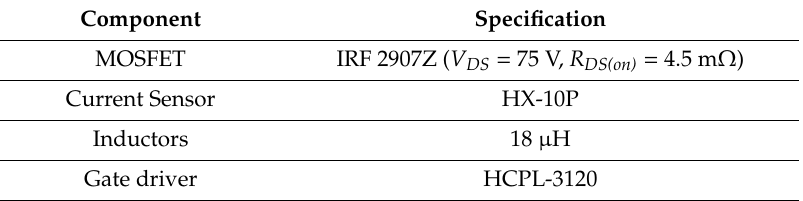
Table 2. Circuit component